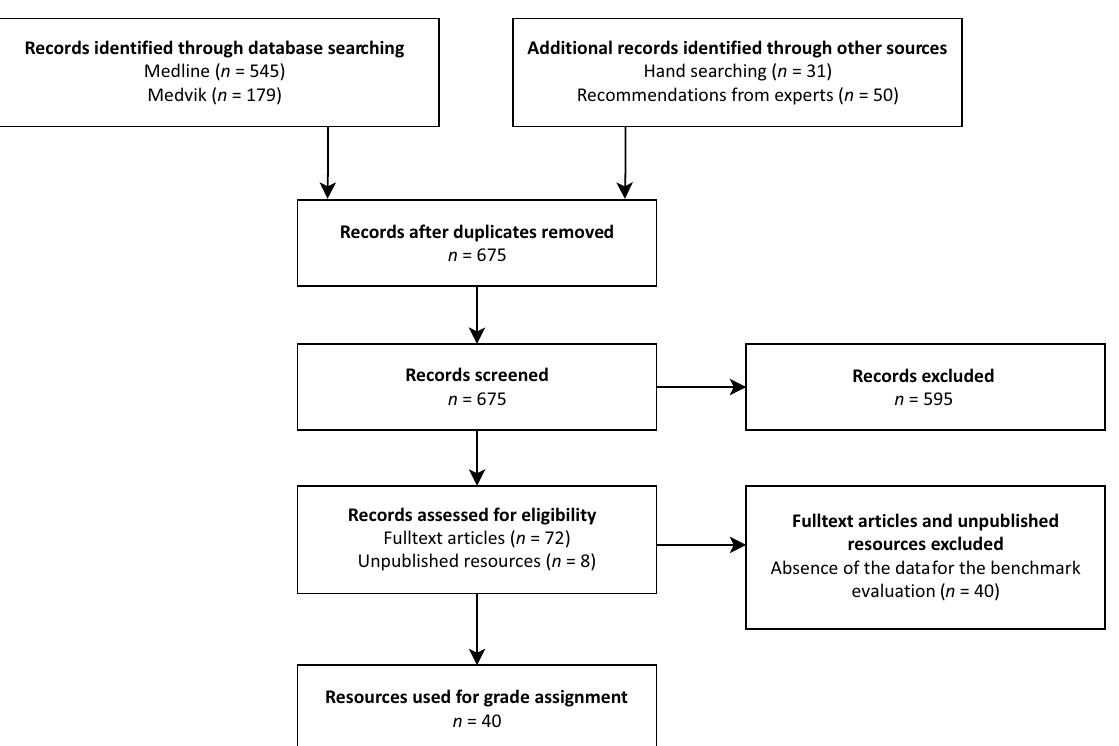
Figure 2. Flow diagram of search strategy for identifying all available resources.